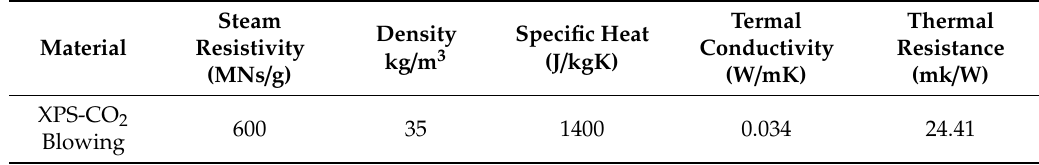
Table 2. Characteristics of the insulating material used.